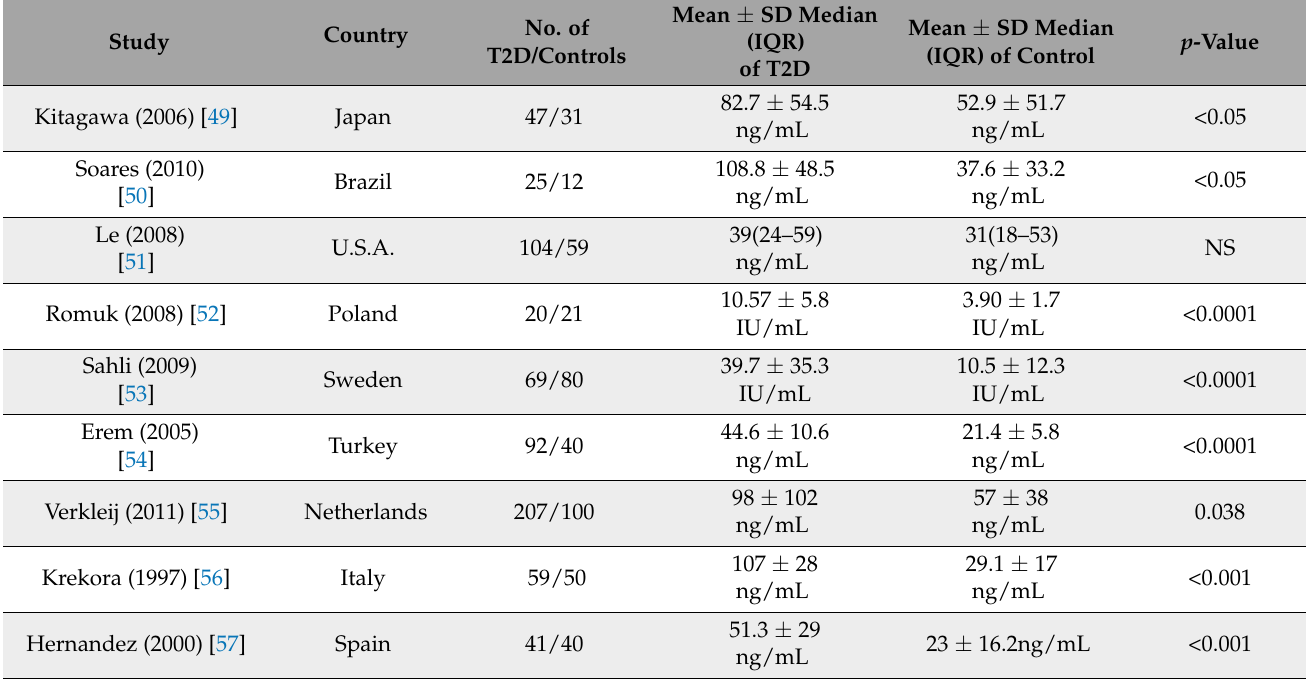
Table 1. Summary of main studies investigating PAI-1 levels in individuals with type 2 diabetes (T2D). Values are presented as mean ± SD or median interquartile range (IQR). Variation in PAI-1 levels is likely due to the different methodologies used to measure protein levels and potential differences between study